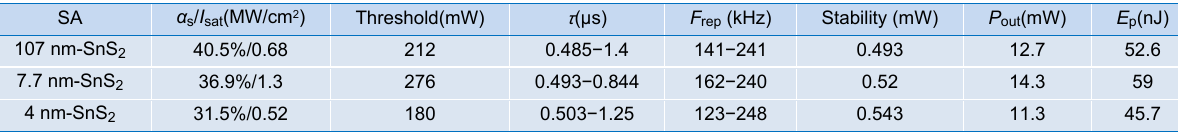
Table 1 | The performance of three different QSFLs adopting distinct